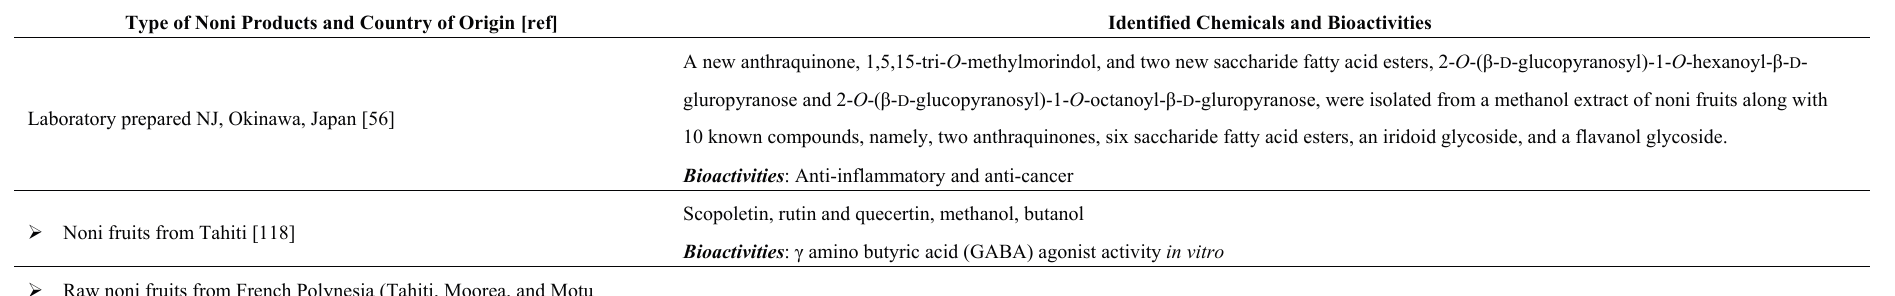
Table A1. Chemicals in diverse noni fruit preparations, including commercial